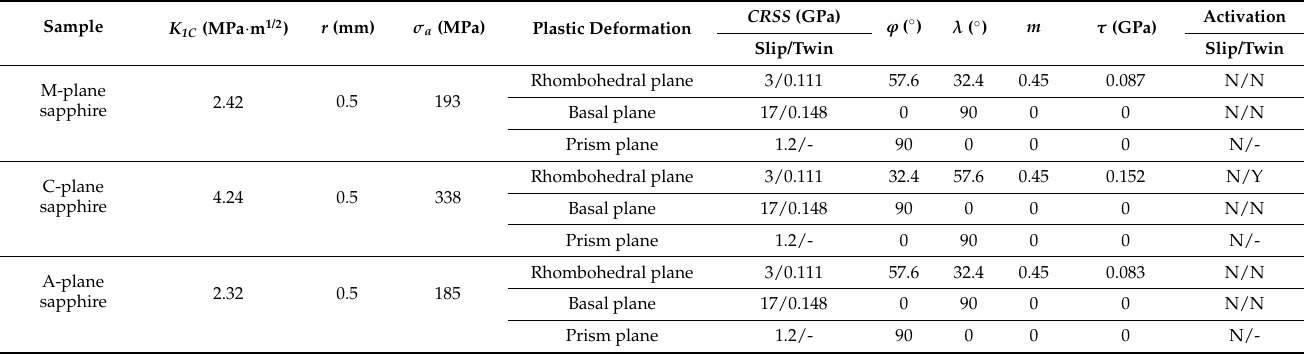
Table 6. Calculation of the resolved shear stress